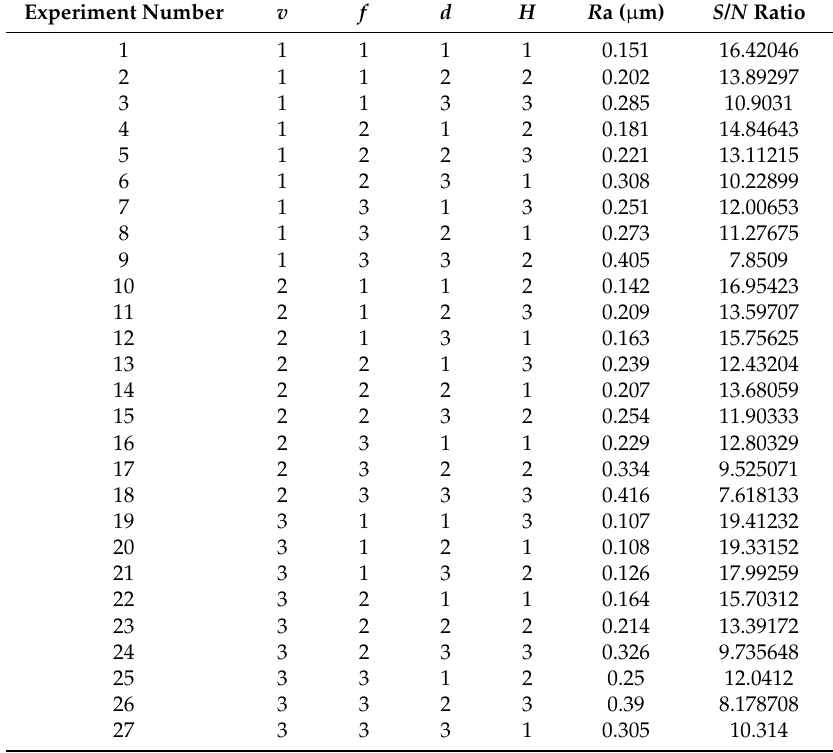
Table 9. The surface roughness result and S / N